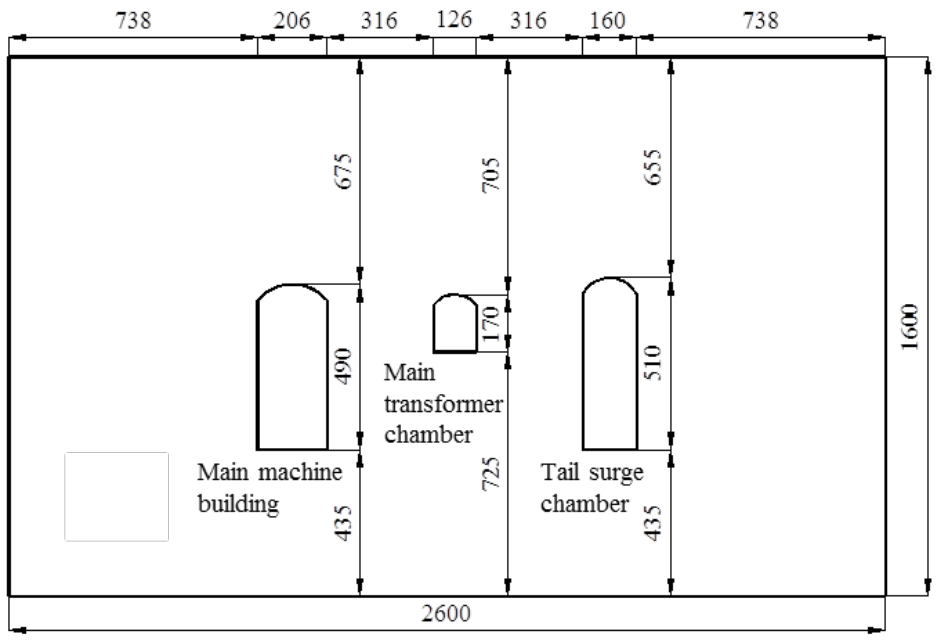
Figure 8. Structure and sizes of the physical model (unit: mm).